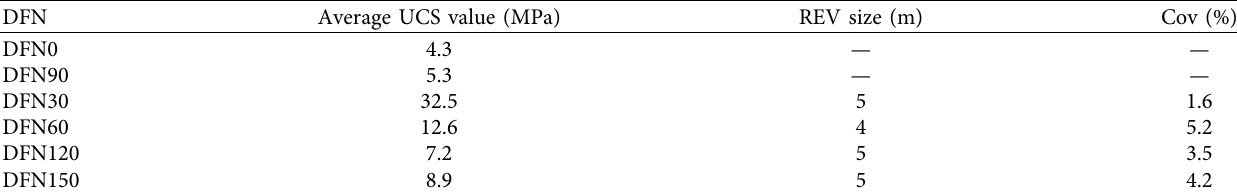
Table 5: Results of the UCS and REV size under different loading directions.